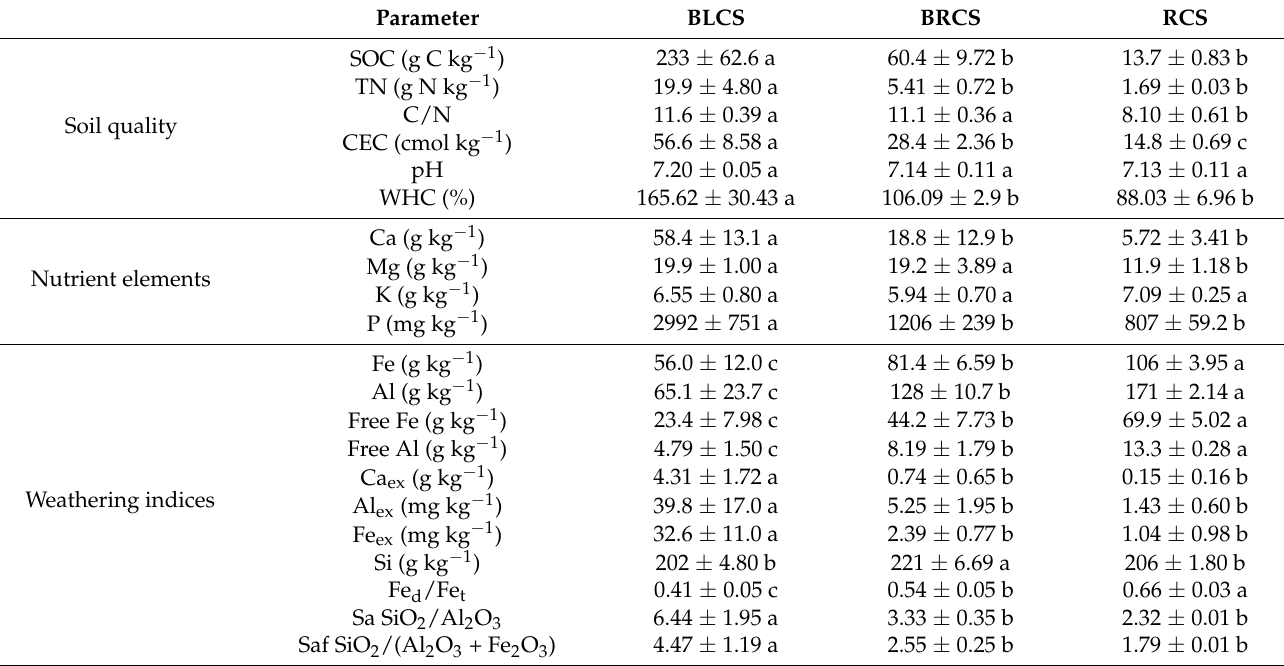
Table 1. Physical and chemical characteristics in black calcareous soils (BLCS), brown calcareous soils (BRCS), and red calcareous soils